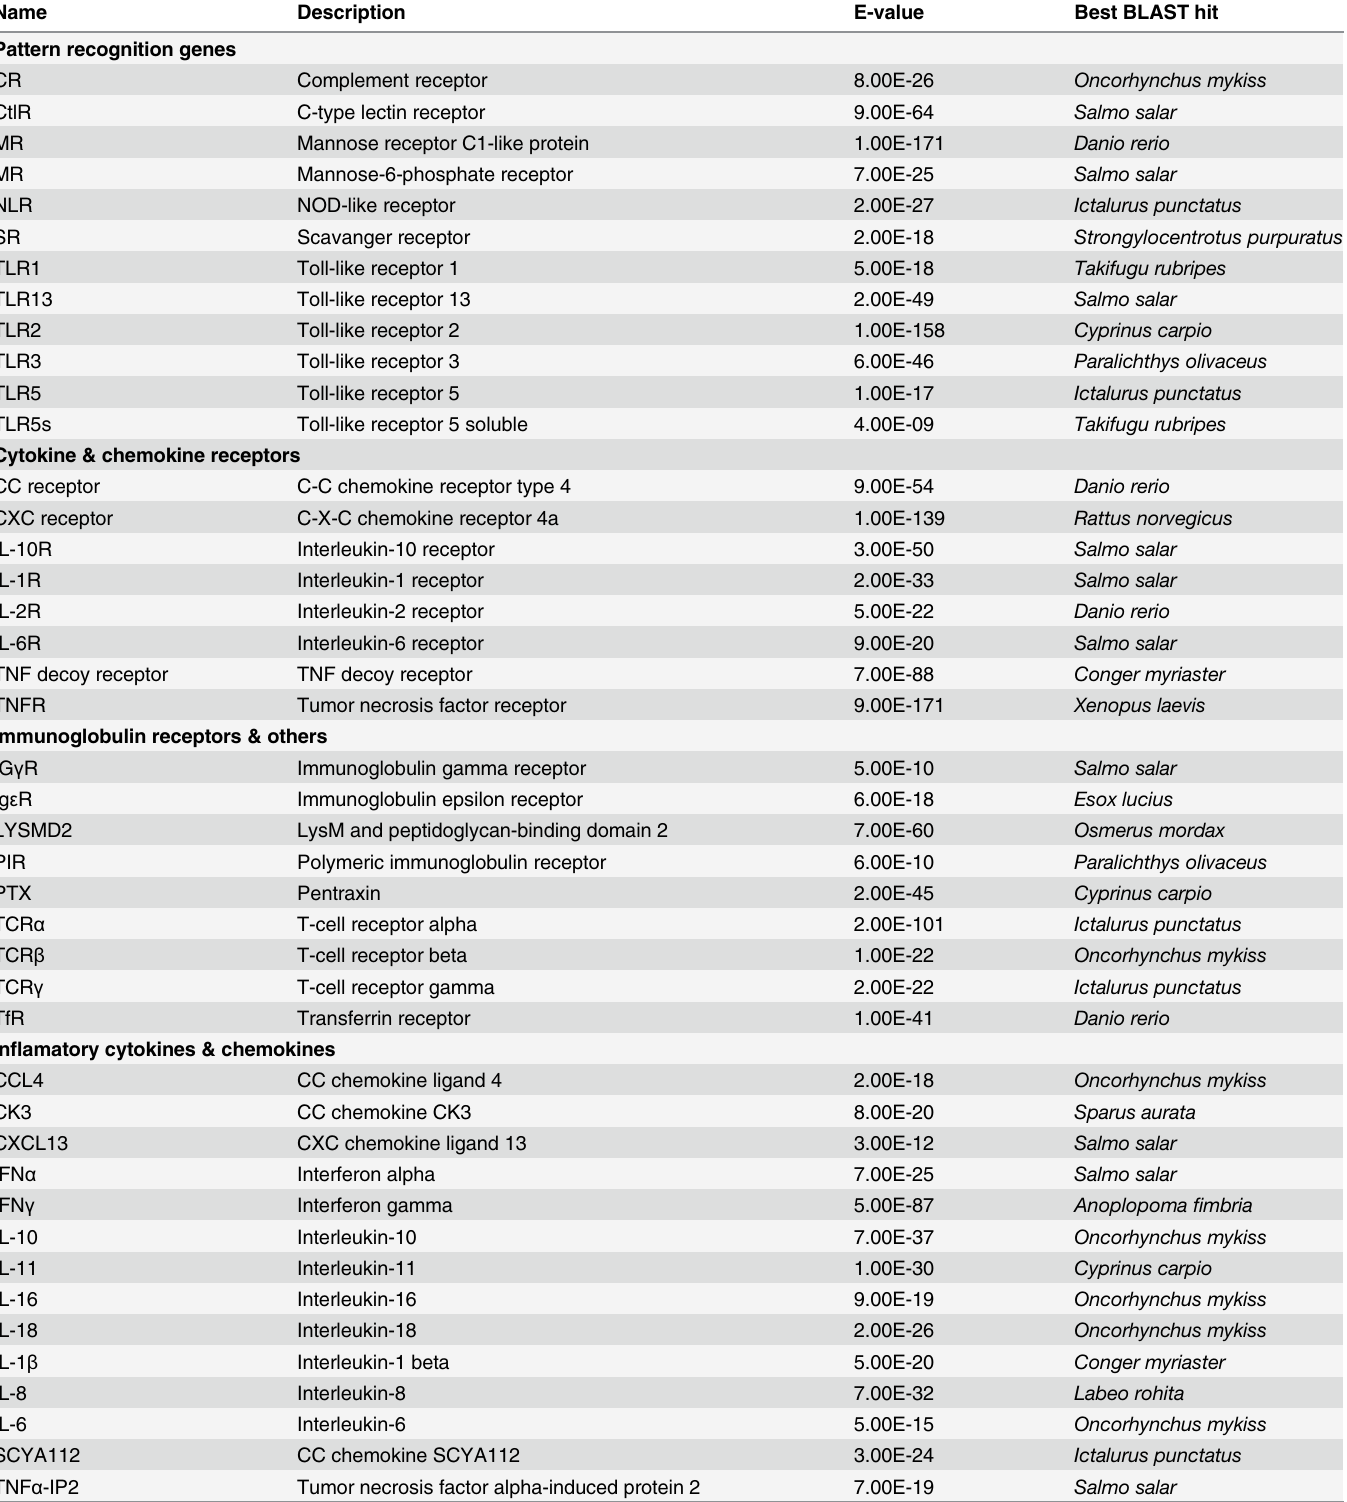
Table 2. Summary of selected immune-relevant transcripts